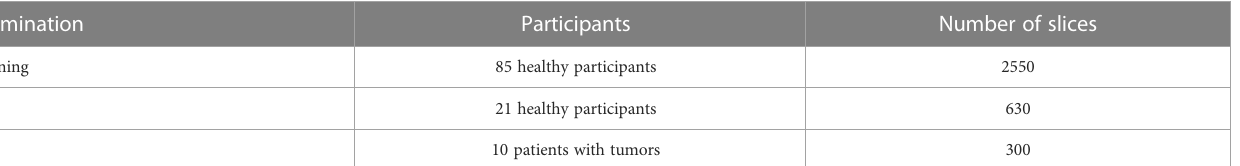
TABLE 1 Number of images used for training and test sets.